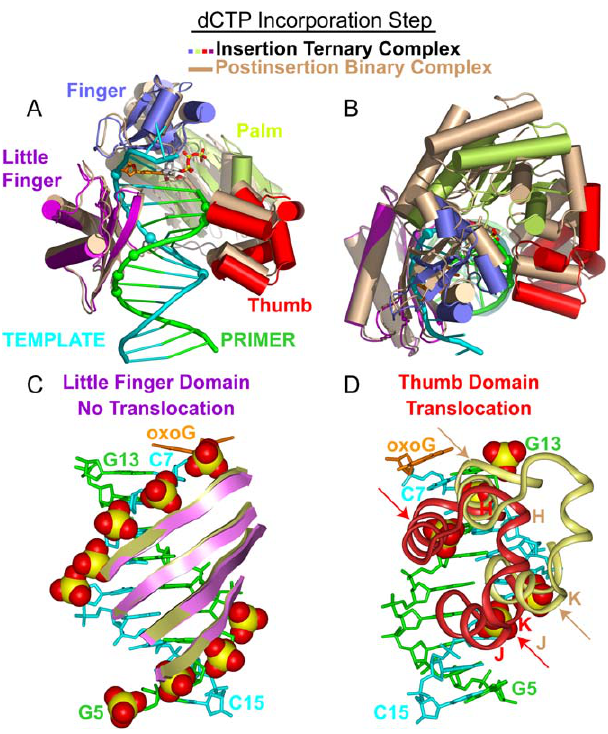
Figure 7. Conformational Transitions of Dpo4 and oxoG-Modified Template-Primer DNA Associated with the Covalent Incorporation